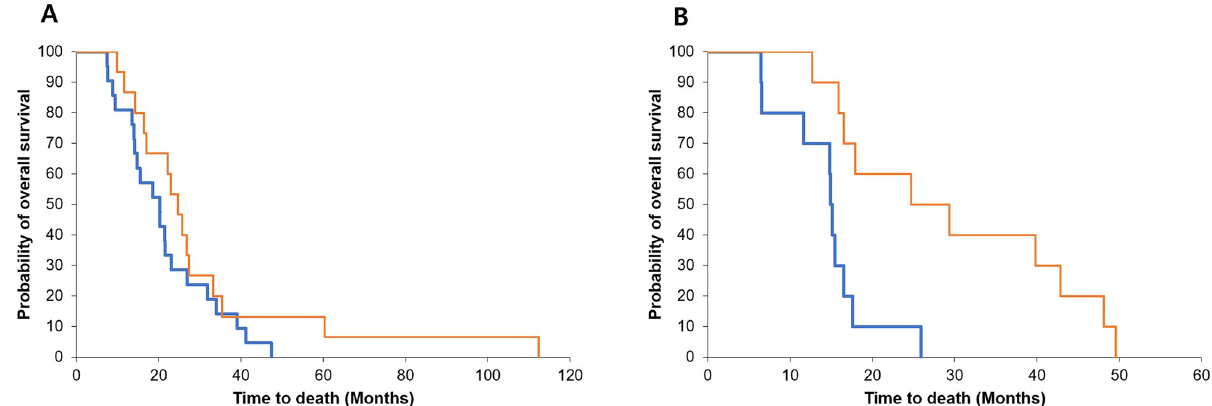
Fig 4. Survival according to the change in the body composition ratio in both gender groups at 24 weeks after resection. The patients were divided into the male group (A) and female group (B), and the effect of the restoration of skeletal muscle mass (SMM) at 24 weeks after surgery on the overall survival (OS) was analyzed using the Kaplan–Meier method. In this Kaplan–Meier analysis, the SMM and OS were not statistically significant in the male group ( P = 0.213) but were significant in the female group ( P = 0.002).